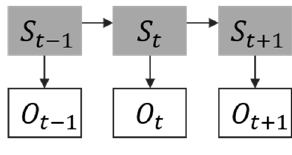
Figure 2. HMM graph model.